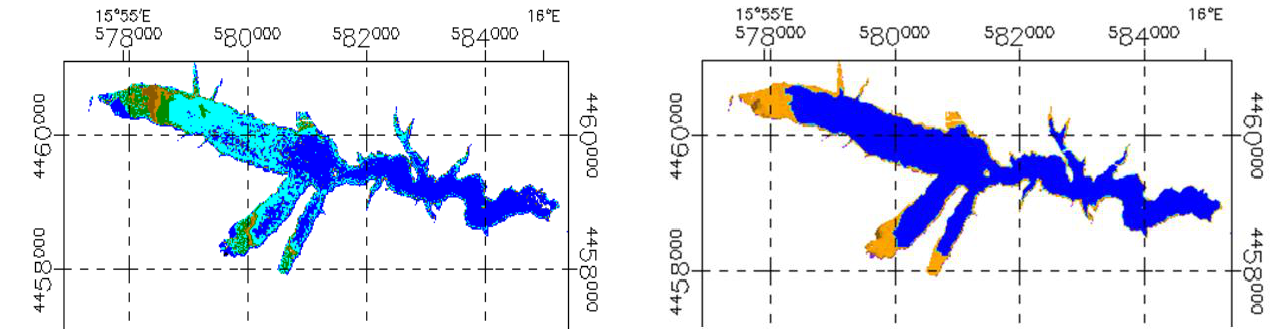
Figure 6. Series of MCI and VNRI maps based on Sentinel-2A images of the Lake Pertusillo acquired, from top to bottom, on 9 December 2016, 26 December 2016, 17 February 2017, 27 February 2017 and 3 August 2017. MCI maps show the evolution of the Chl-a in the lake whereas VNRI maps show the increase and decrease (3rd of August) in the presence of pollution related to oil.